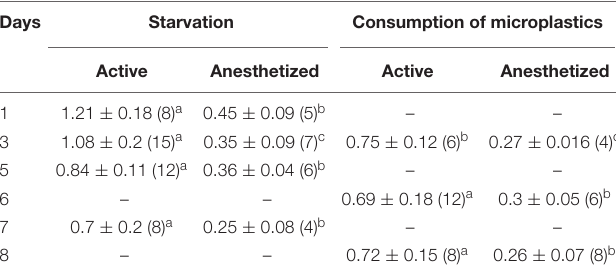
TABLE 3 | Total and basal weight specific respiration rates ( µ g O 2 mg − 1 h − 1 ) of active and anesthetized Calanus helgolandicus females respectively, exposed to starvation (except Day 1 of experiment) and microplastics [number of replications in parenthesis, Mean ± Standard Deviation SD ; low-case letters (a,b,c) denote significant variable differences among each active and anesthetized groups using Duncan’s Multiple Range test, P <